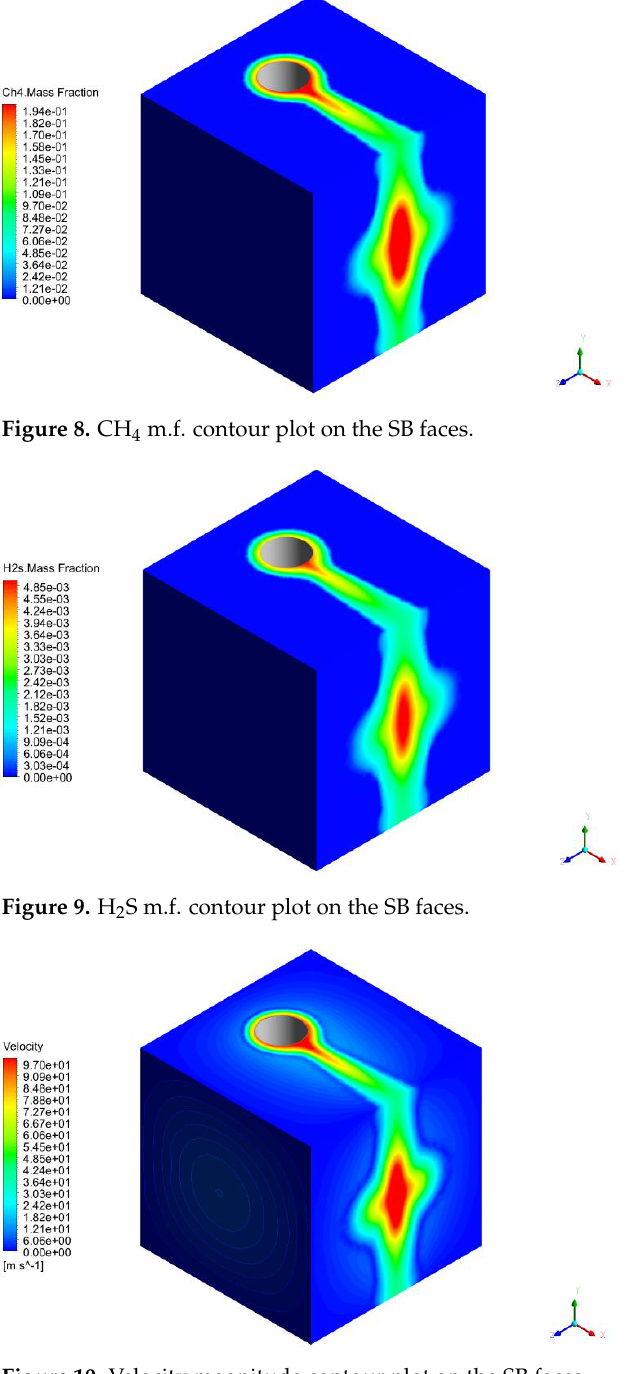
Figure 10. Velocity magnitude contour plot on the SB faces.